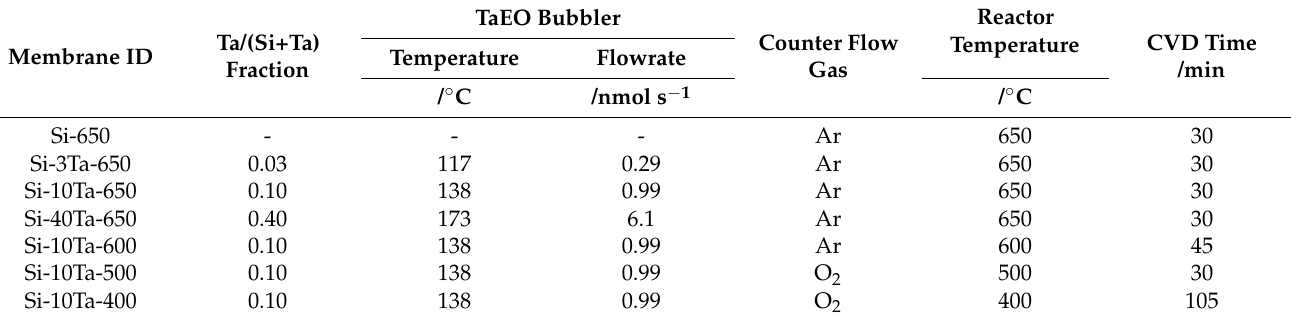
Table 2. CVD synthesis parameters. Ar flow rates through the bubblers were constant at 3.7 µ mol s −